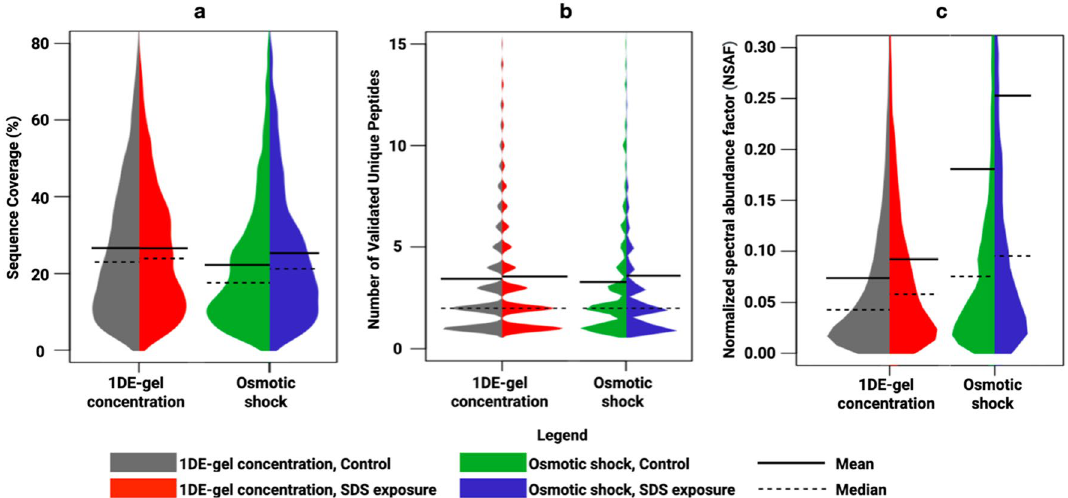
Figure 3. Qualitative and quantitative comparison of the identified proteins extracted from control and SDS-exposed HaCaT keratinocytes using 0.2% SDS lysis + 1DE-gel concentration approach and osmotic shock procedure. Violin plots give a glance at the statistics of ( a ) validated sequence coverage percentages on proteins; ( b ) the number of validated unique peptides identifying the proteins; ( c ) spectrum counting NSAF values scatter. Solid lines indicate the means, and dashed lines—the median